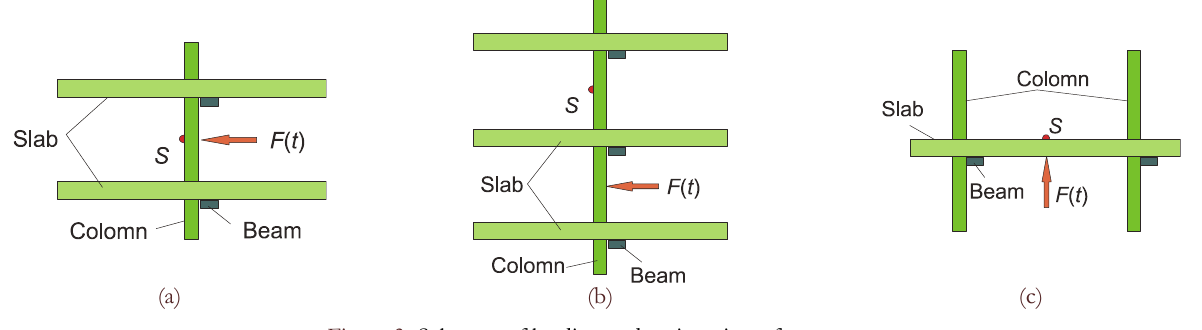
Figure 3: Schemes of loading and registration of